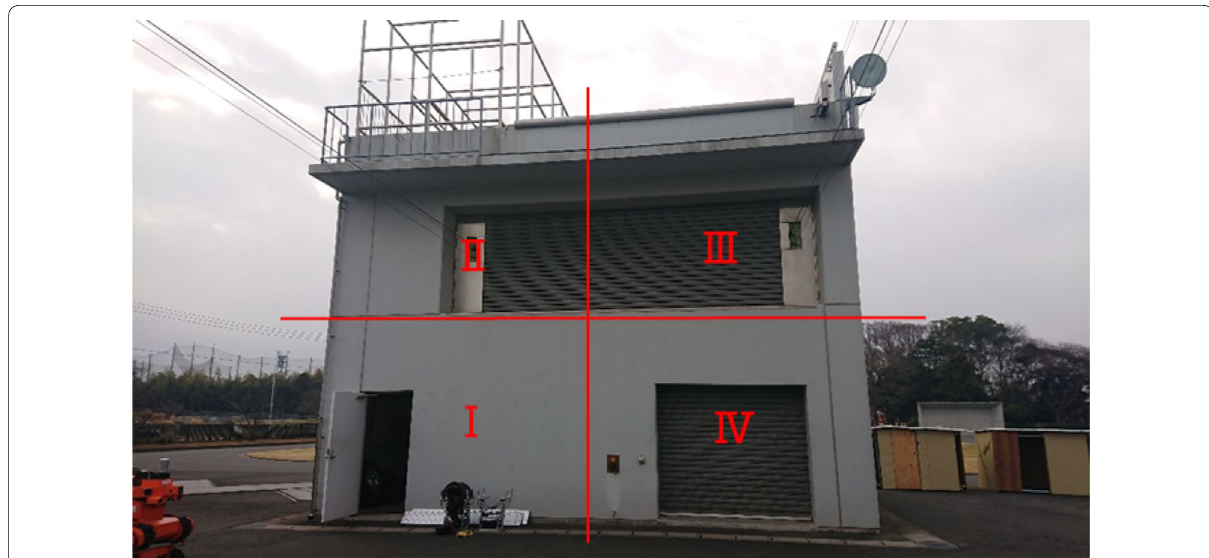
Fig. 9 Area that is divided into four sections on one side of the building